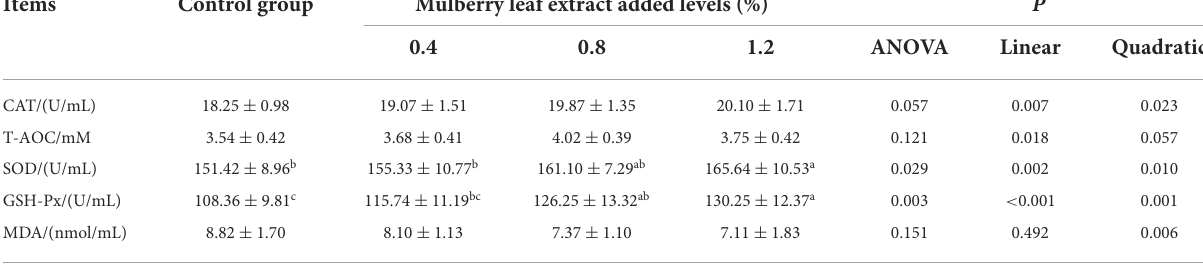
TABLE 5 Effects of mulberry leaf extract on serum antioxidant capacity of laying